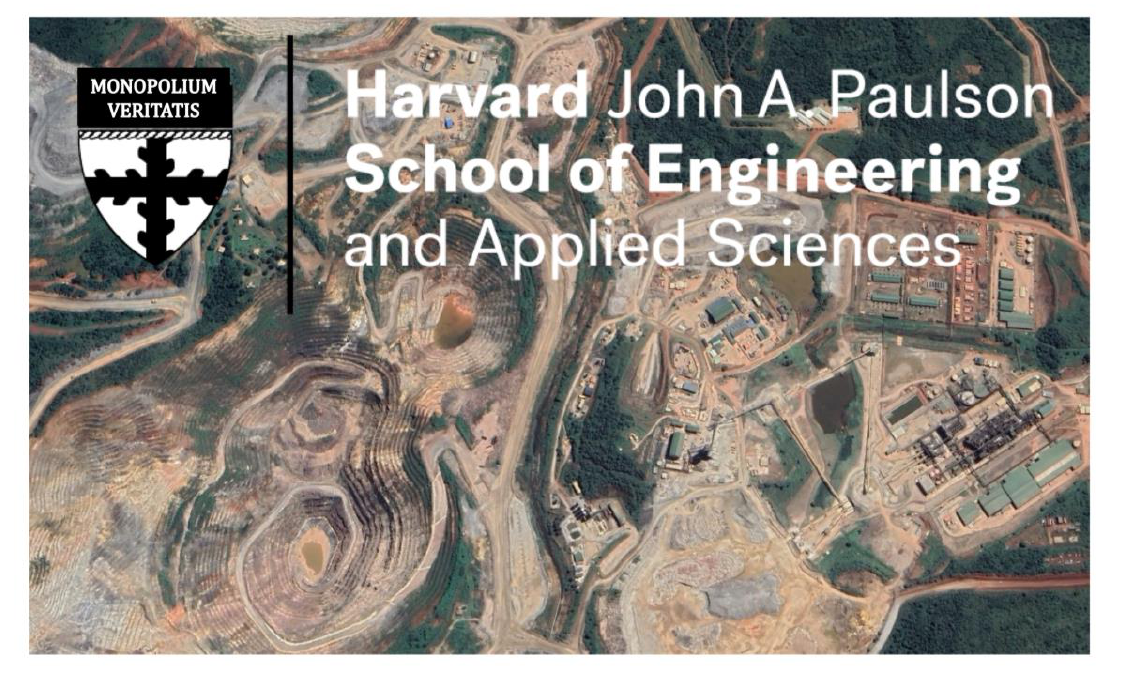
Figure 1. Superspreading nexus. Satellite image of the Kibali gold mine in DRC superimposed with a revised logo of the John A. Paulson School of Engineering and Applied Sciences (SEAS) at Harvard University (translation from Latin: Monopoly on truth) (image source: Google Earth). Kibali is co-owned by AngloGold Ashanti (45 percent), Barrick Gold Corporation (45 percent) following its merger with Randgold Resources Limited, and Société Minière de KiloMoto (SOKIMO) (10 percent), a state-owned gold mining company. In 2015, John A. Paulson, the largest single shareholder of AngloGold Ashanti, donated US$400 million – the largest gift in the university’s history – to support SEAS (J. Sachs